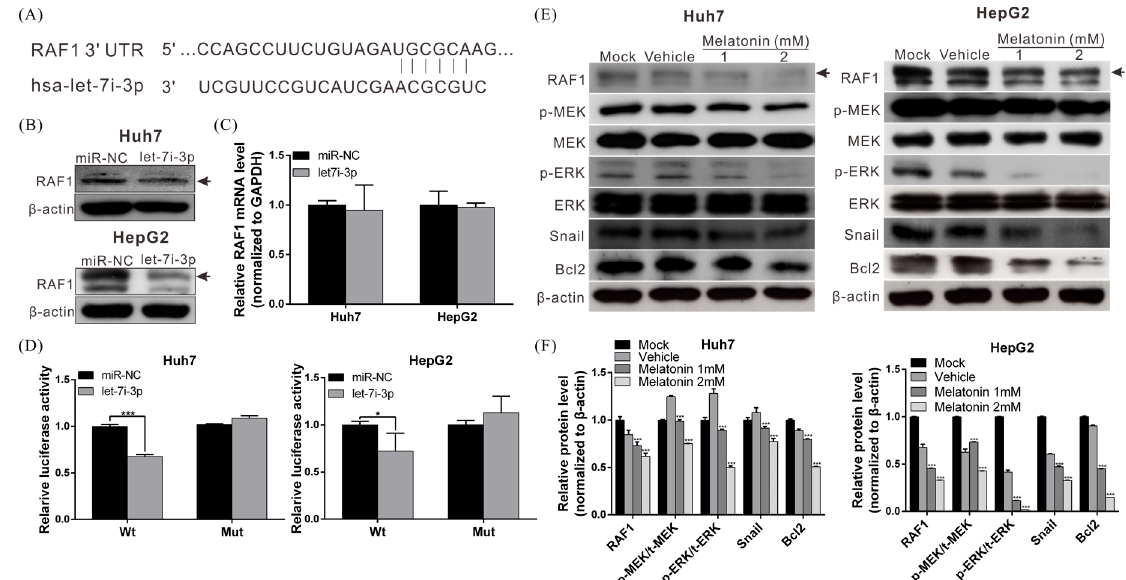
Figure 4. miRNA let7i-3p directly binds to the 3 ′ UTR of RAF1 mRNA and suppresses RAF1 protein expression. ( A ) Schematic representation of the predicted let7i-3p binding region in the 3 ′ UTR of RAF1 mRNA. Western blotting ( B ) and quantitative RT PCR ( C ) were performed to examine the RAF1 level (black arrow) in HCC cells transfected with 50 nM let7i-3p mimic or control miRNA (miR-NC) for 48 h. ( D ) Huh7 and HepG2 cells were cotransfected with pmirGLO-RAF1 reporter plasmids containing the wild-type (Wt) or mutated (Mut) 3 ′ UTR fragments of RAF1 and the let7i-3p mimic or control miRNA (miR-NC), and luciferase activity was analyzed at 48 h after transfection. Data are expressed as means ± SD of three independent experiments; * p < 0.05, *** p < 0.001. ( E ) Western blotting was used to examine the levels of RAF1 (black arrow) and downstream proteins in HCC cells treated with melatonin for 48 h, and the results were quantified ( F ); *** p < 0.001.